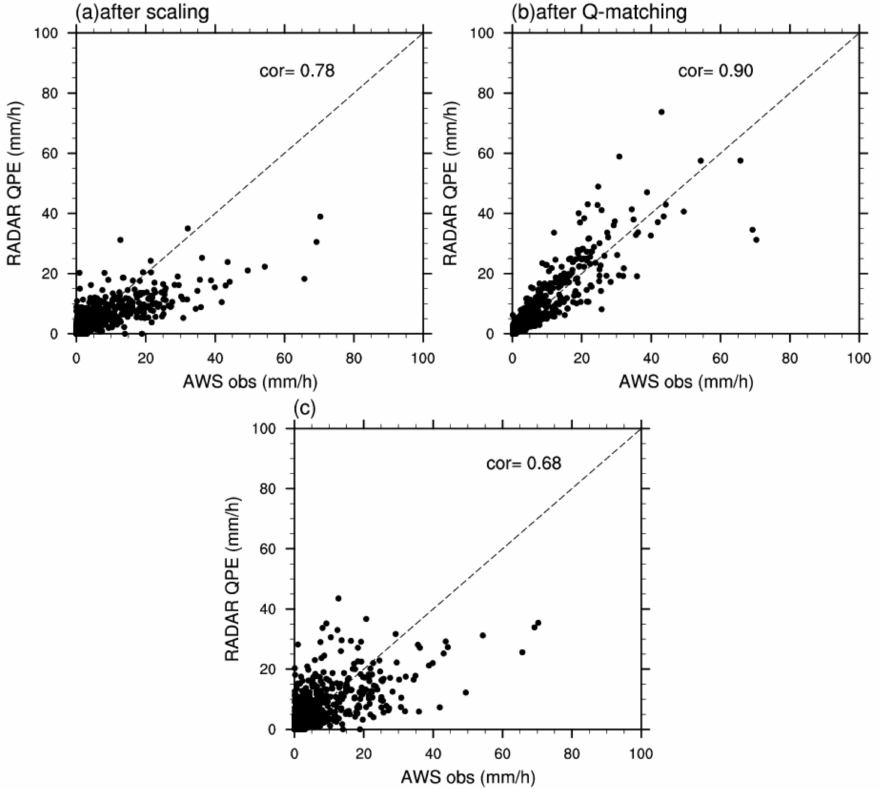
Figure 9. Scatter plot of hourly rainfall on 07 UTC 20 August 2020 between AWS and radar QPE ( a ) after correction by scaling, ( b ) after correction by Q-matching, and ( c ) before correction. The horizontal axis represents AWS rainfall, and the vertical axis represents radar QPE. The correlation coefficient is also